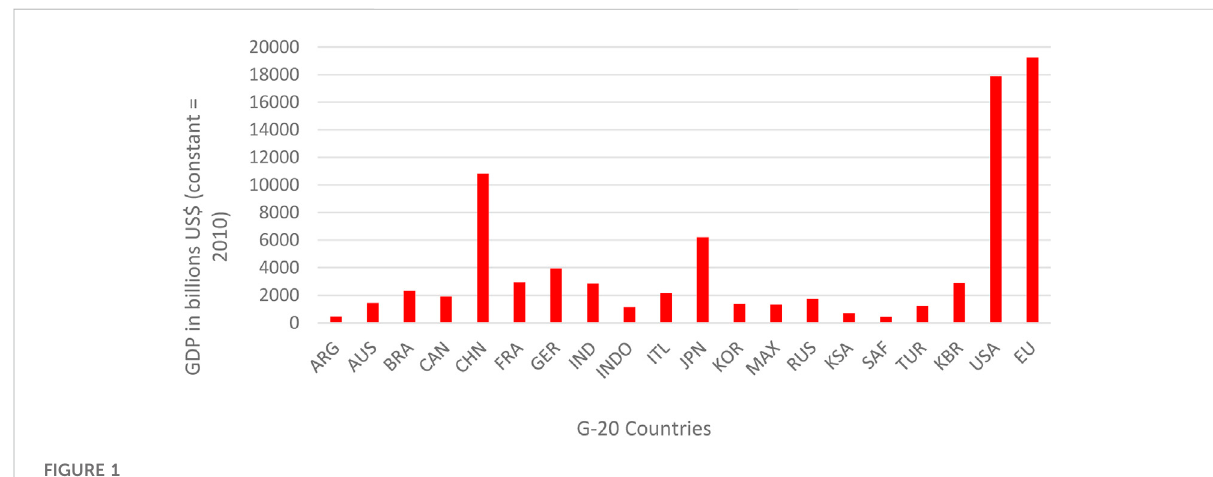
FIGURE 1 GDP of G-20 countries based on 2018 in billions of US$ (constant =